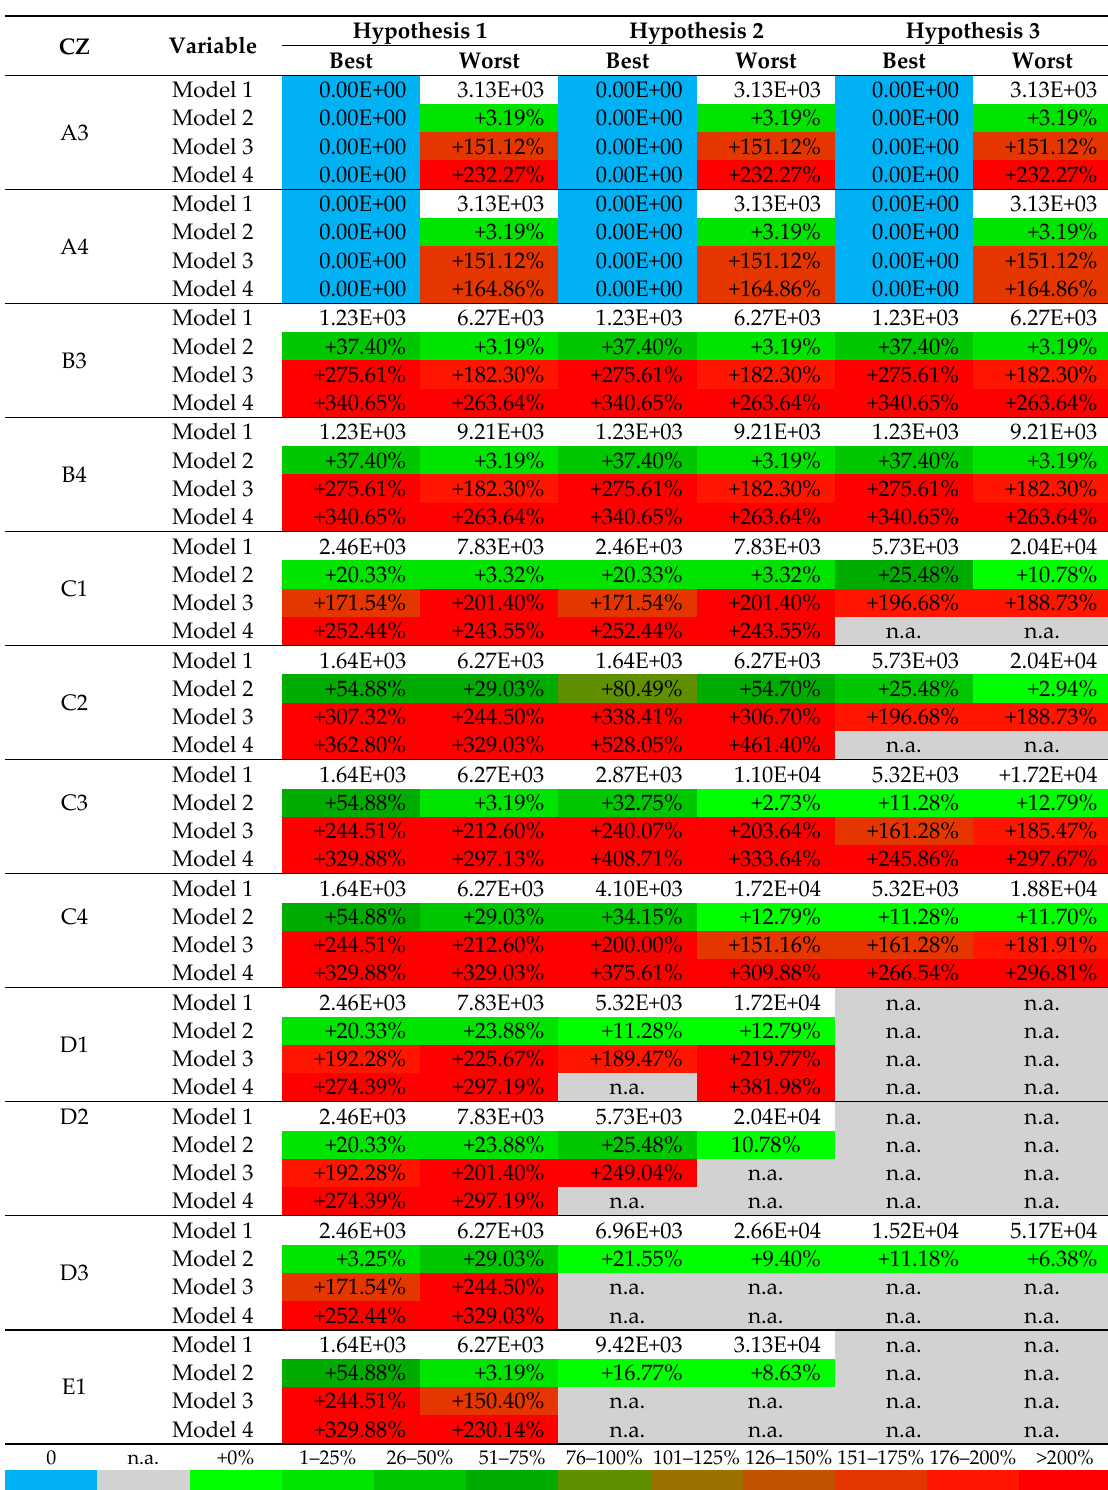
Table 10. Increase of emissions due to the compactness for the best and worst set ups.